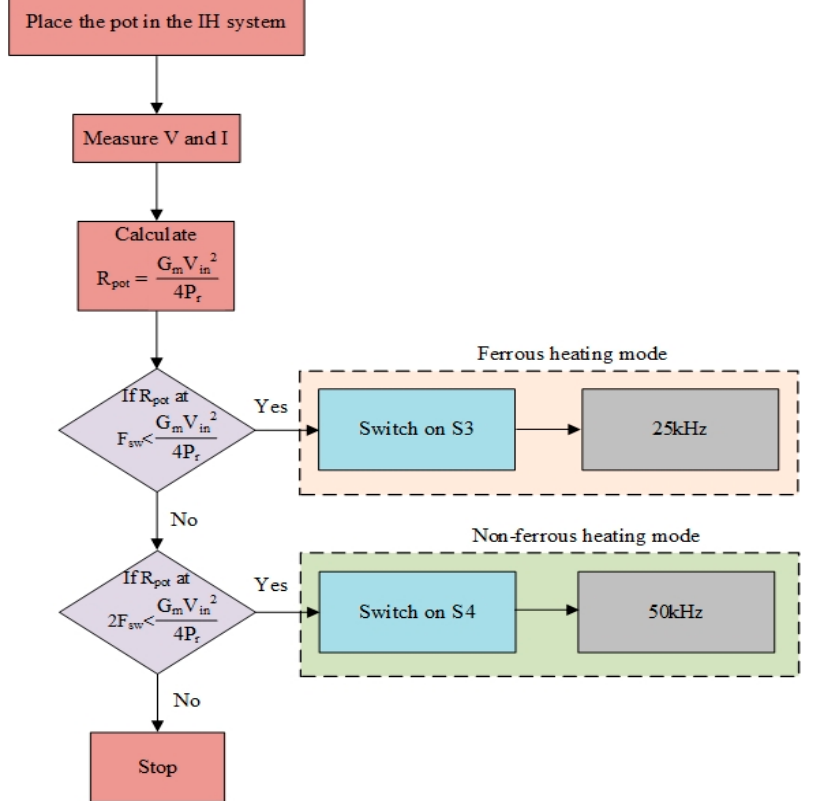
Figure 9. Flowchart for operational mode selection. Table 1. Circuit parameters for different modes of